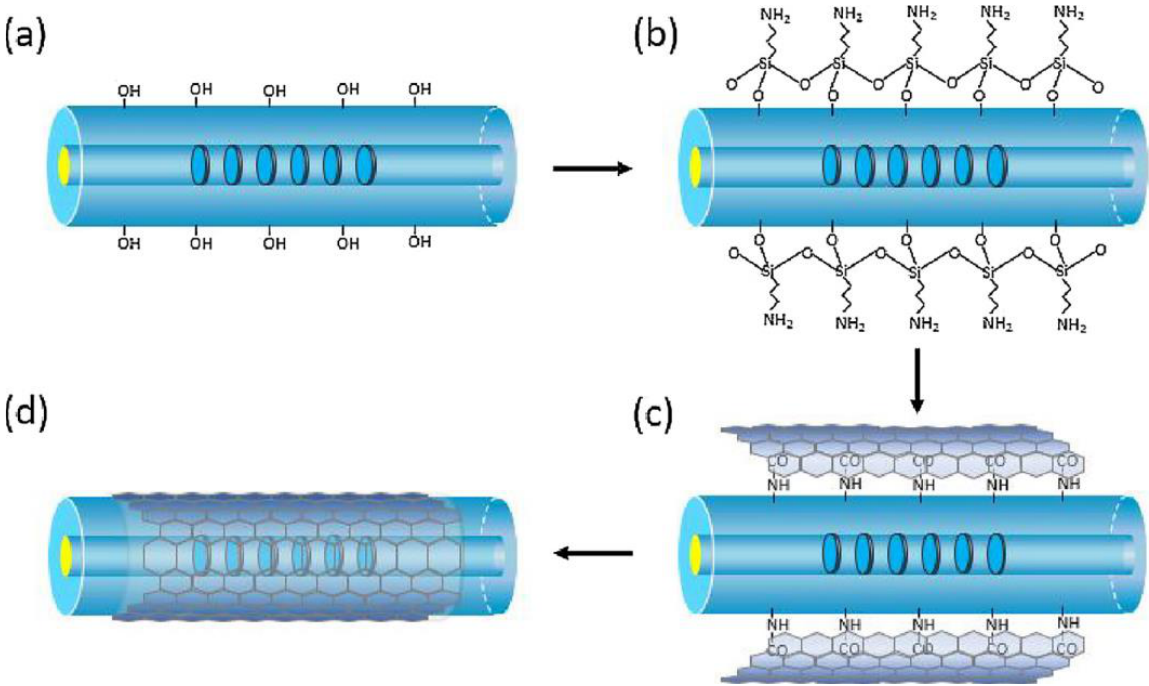
Figure 10. Schematic of GO deposition on LPFG-based device. ( a ) The process of alkaline treatment, ( b ) APTES silanization, ( c ) the epoxy group of GO reacted with amino group of APTES-silanized fiber surface, and ( d ) GO nanosheets were deposited onto fiber surface. Reprinted with permission from [85]. Copyright © 2018 Elsevier B.V.